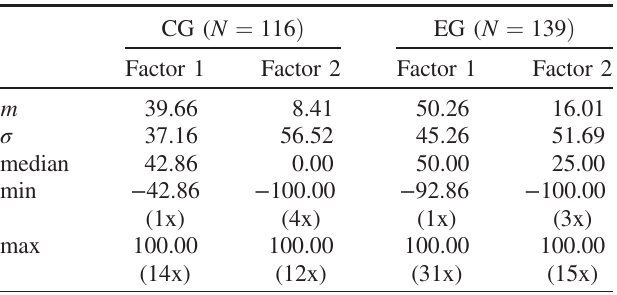
indices for factor 1 properties of quantum objects and factor 2 quantum objects ’ behavior retained from PCA for control and experimental group students, respectively. The number of stu- dents who achieved the respective minimum and maximum scores for both CG and EG are noted in